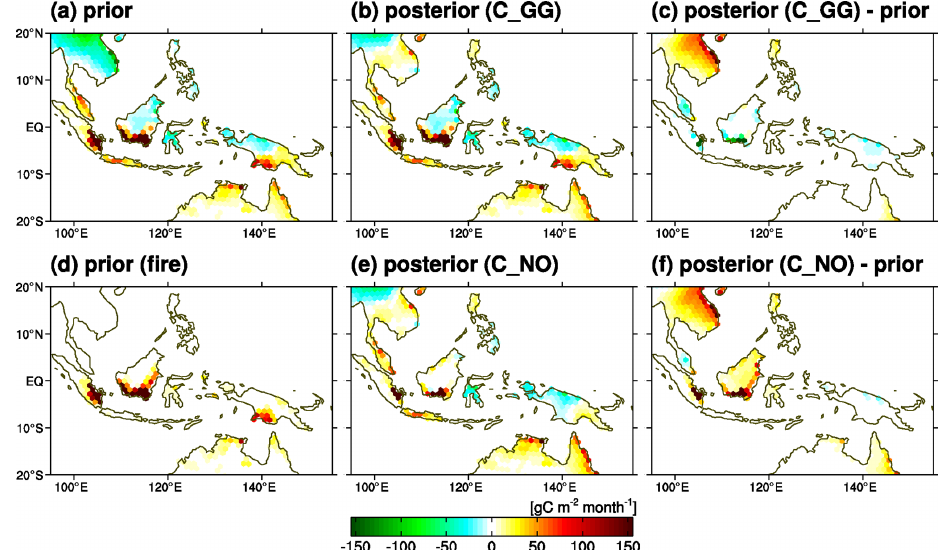
Figure 8. Prior (a) and posterior ( b : C_GG, e : C_NO) surface CO 2 flux distributions averaged for September 2015. Differences between prior and posterior fluxes (c, f) and prior fire emissions (d) are also shown. Note that the prior estimate of (a) was used both for C_GG and C_NO, while the prior fire estimate of (d) was used only for